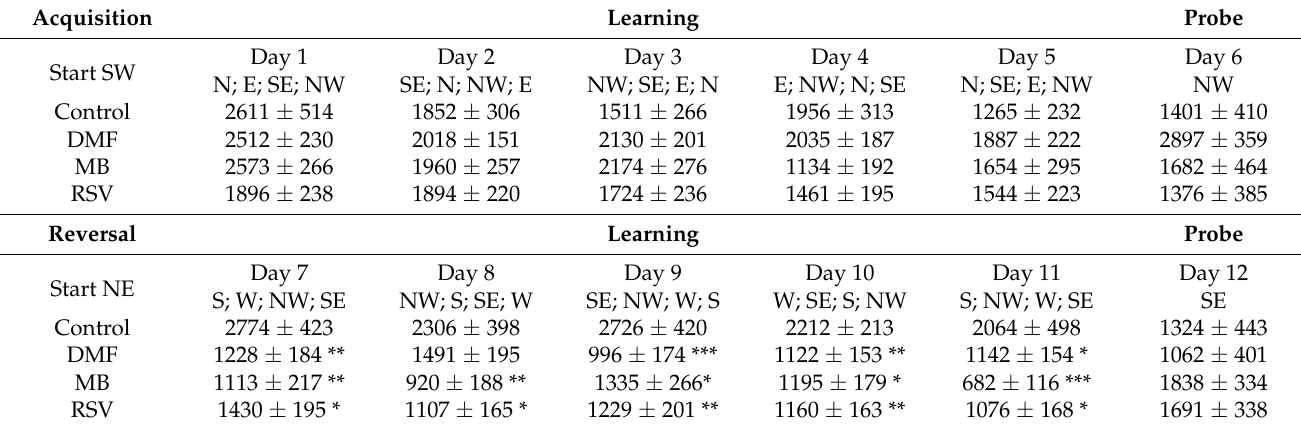
Table 2. The distance that mice swam for the platform search.